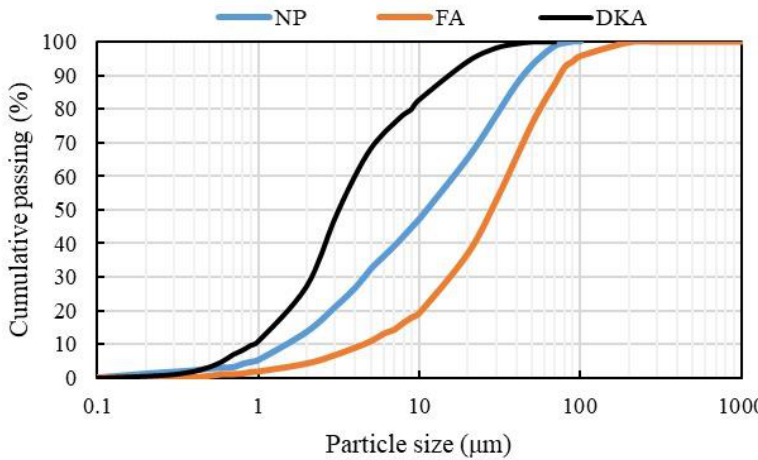
Figure 5. Particle size distributions of fine aggregate and coarse aggregate.